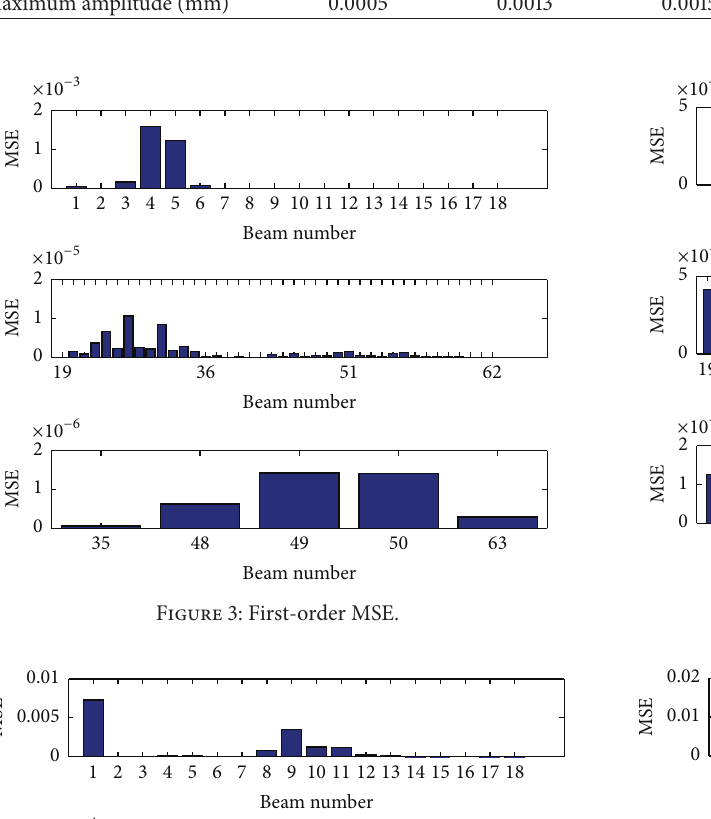
Figure 3: First-order MSE.